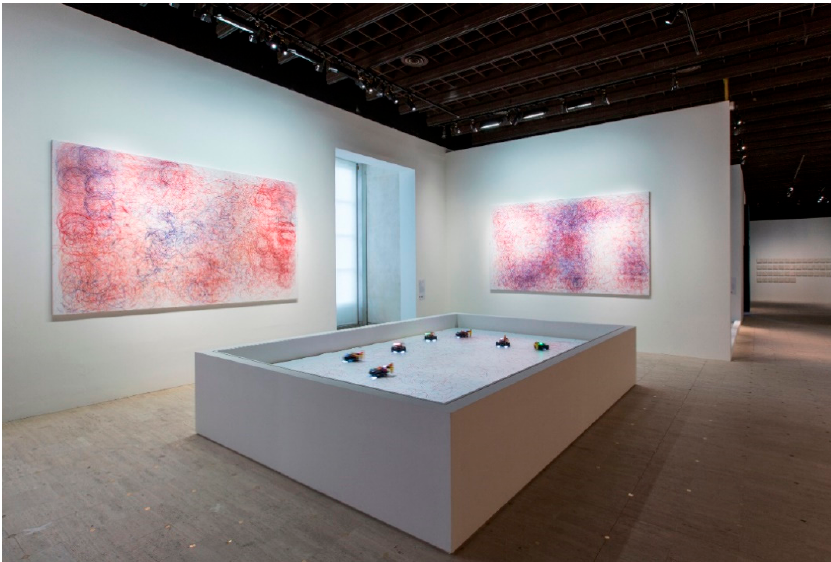
Figure 2. Artbot arena as installed at the Spring 2018 Grand Palais exhibition “Artists and Robots”. Photo ©2018 Aldo Paredes RMNGP and used by permission.